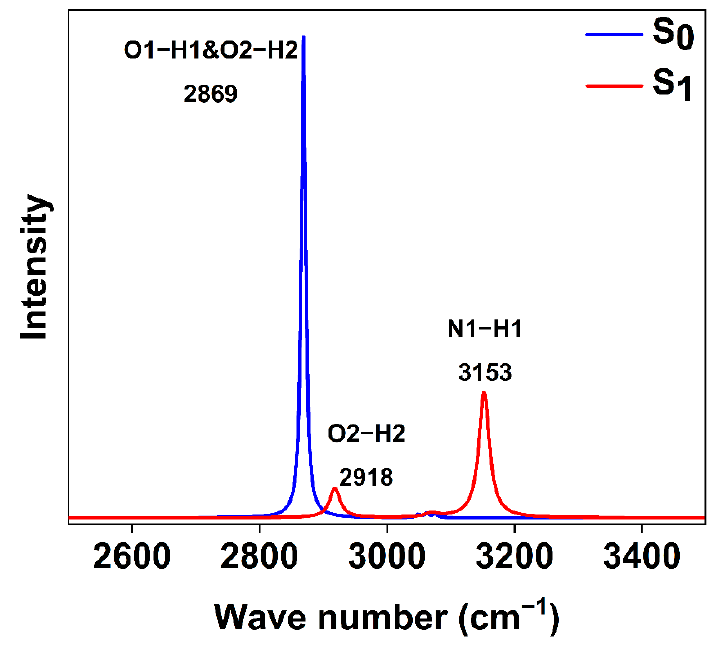
Figure 5. Calculated S 0 state and S 1 state infrared spectrum based on the single ESIPT structure of BP(OH) 2 in hexane.